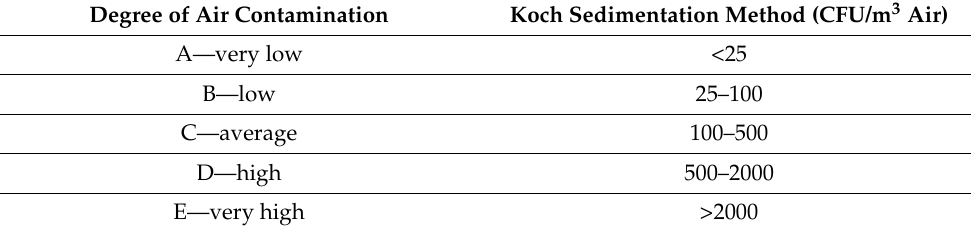
Table 1. Assessment of the degree of air contamination in a room according to the health rules applied to non-industrial institutions (Source: Commission of European Communities